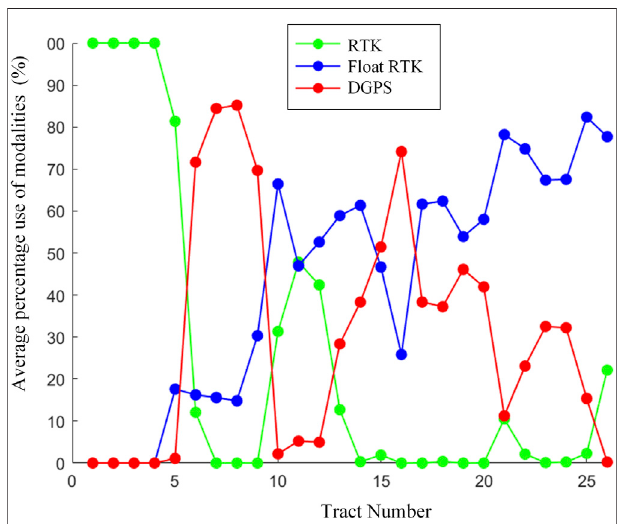
FIGURE 5 | Average percentage use of the different modalities in each track.